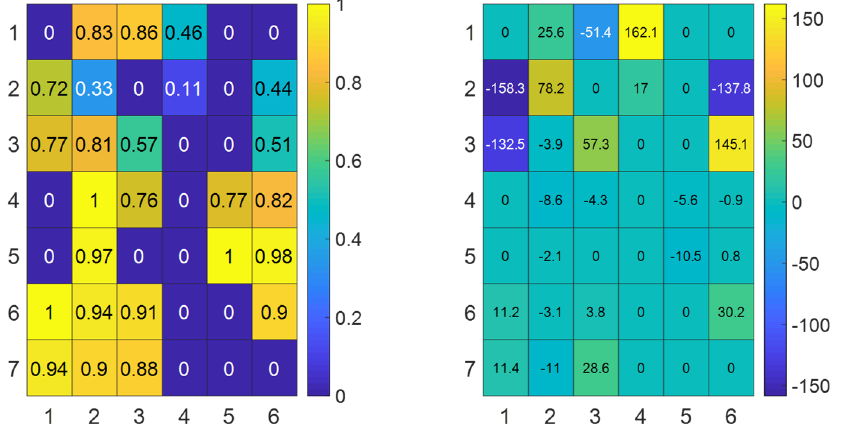
Figure 12. Final position distribution and amplitude–phase distribution of the subarray at 40 ‐ degree scan angle.